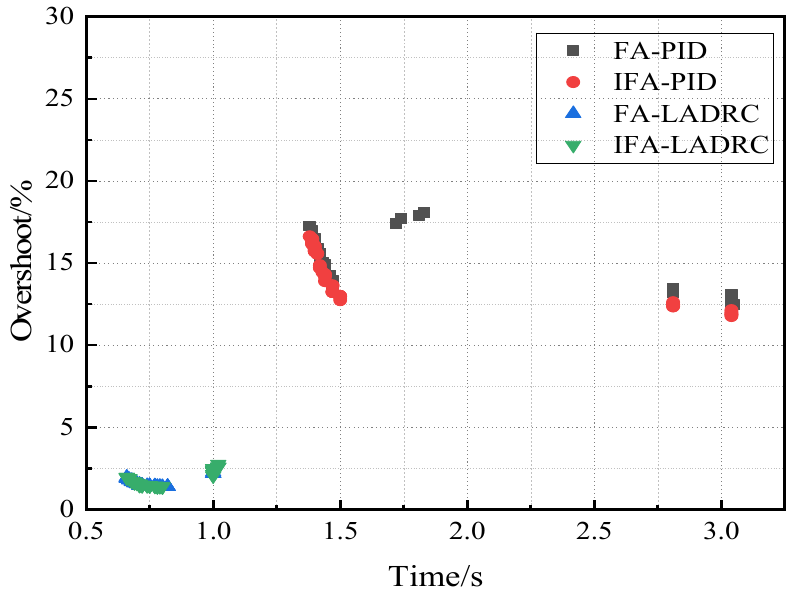
Figure 14. Performance indicators of four control methods under Monte Carlo simulation.